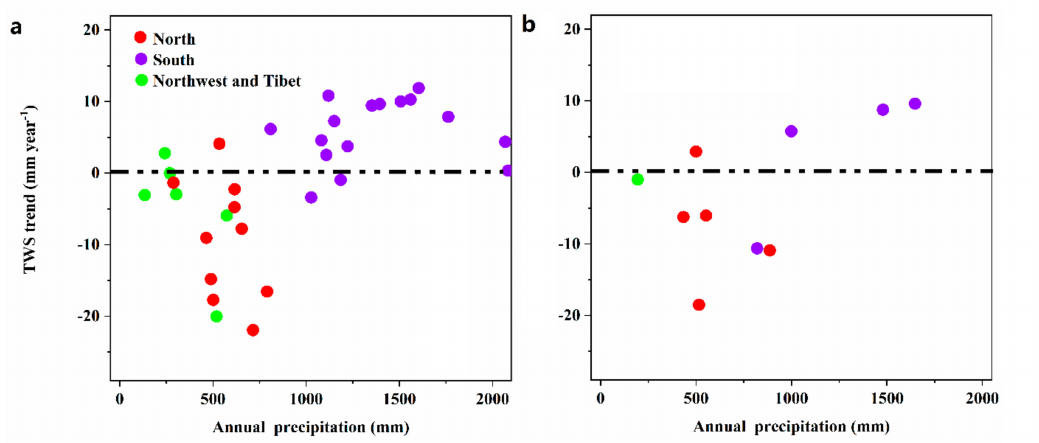
Figure 10. Relationship between terrestrial water storage trends and annual precipitation during 2003–2016. ( a ) Per the province. ( b ) Per the basin. For detailed meaning of the North, South, Northwest and Tibet, refer to Figure